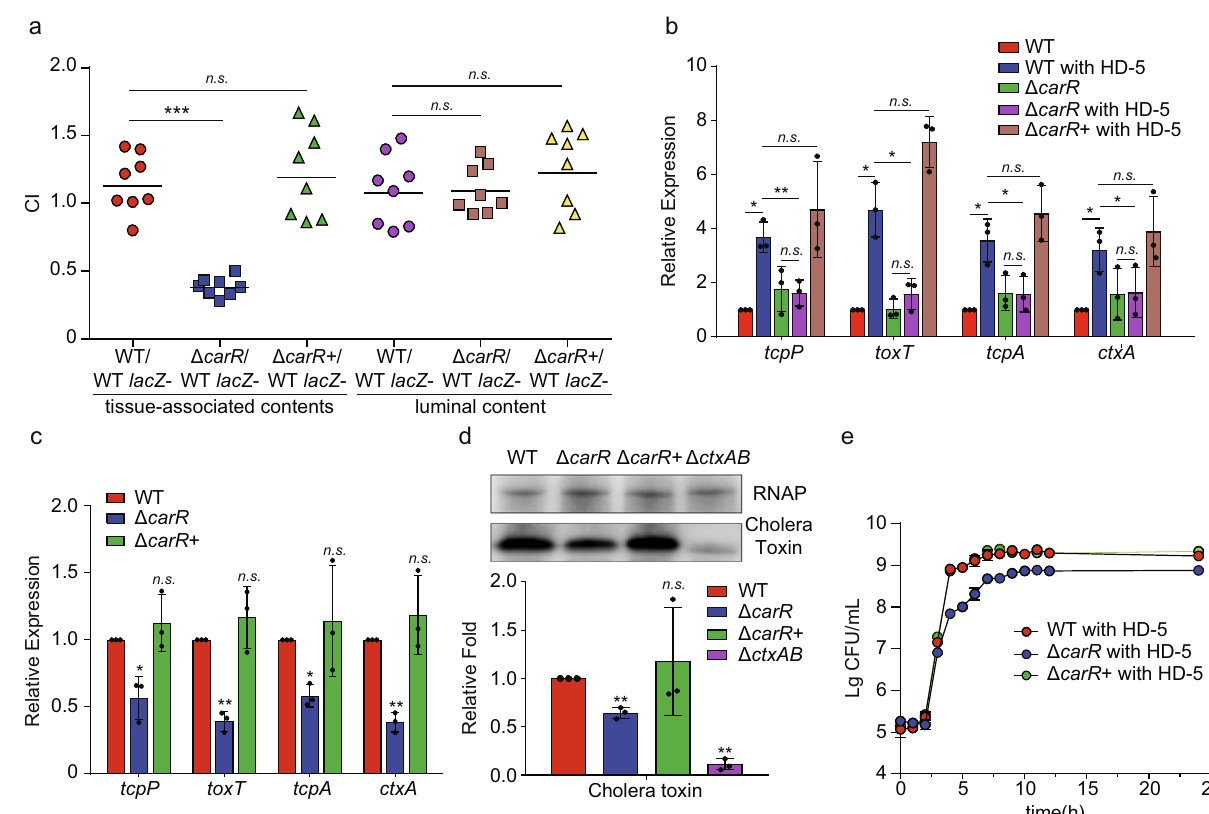
Fig. 4 CarSR is required for V. cholerae pathogenicity. a In vivo competition assay of WT, Δ carR , and Δ carR + in luminal contents and tissue-associated contents ( n = 8). CI is de fi ned as the output ratio of mutant strains to WT lacZ − divided by the input ratio of mutant strains to WT lacZ − . Each symbol represents the CI in an individual mouse; horizontal bars indicate the median. b , c qRT-PCR analysis of virulence genes expression in WT, Δ carR , and Δ carR + in AKI medium containing 0 and 50 μ g/mL HD-5 ( b ) and in the small intestine of mice ( c ). Data are presented as mean ± SD ( n = 3). d Western blotting and quantitative analysis of cholera toxin in WT, Δ carR , Δ carR + and Δ ctxAB in AKI medium containing 50 μ g/mL HD-5. RNA polymerase (RNAP) was used as a loading control. Δ ctxAB was used as a negative control. Data are presented as the mean ± SD ( n = 3). e Growth of WT, Δ carR , Δ carR + in AKI medium containing 50 μ g/mL HD-5. Data represents the mean ± SD ( n = 3). Signi fi cance was determined by two-sided Mann – Whitney U test ( a ) or